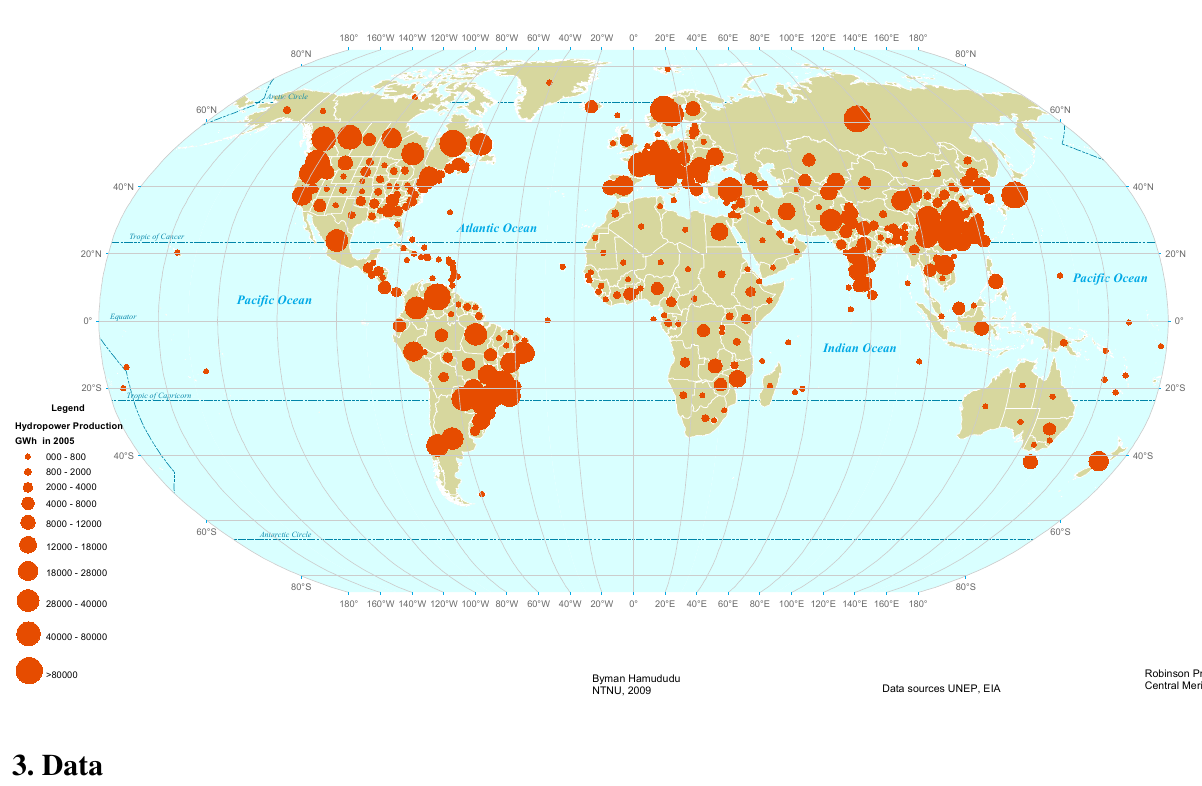
Figure 4. Hydropower generation (GWh) in